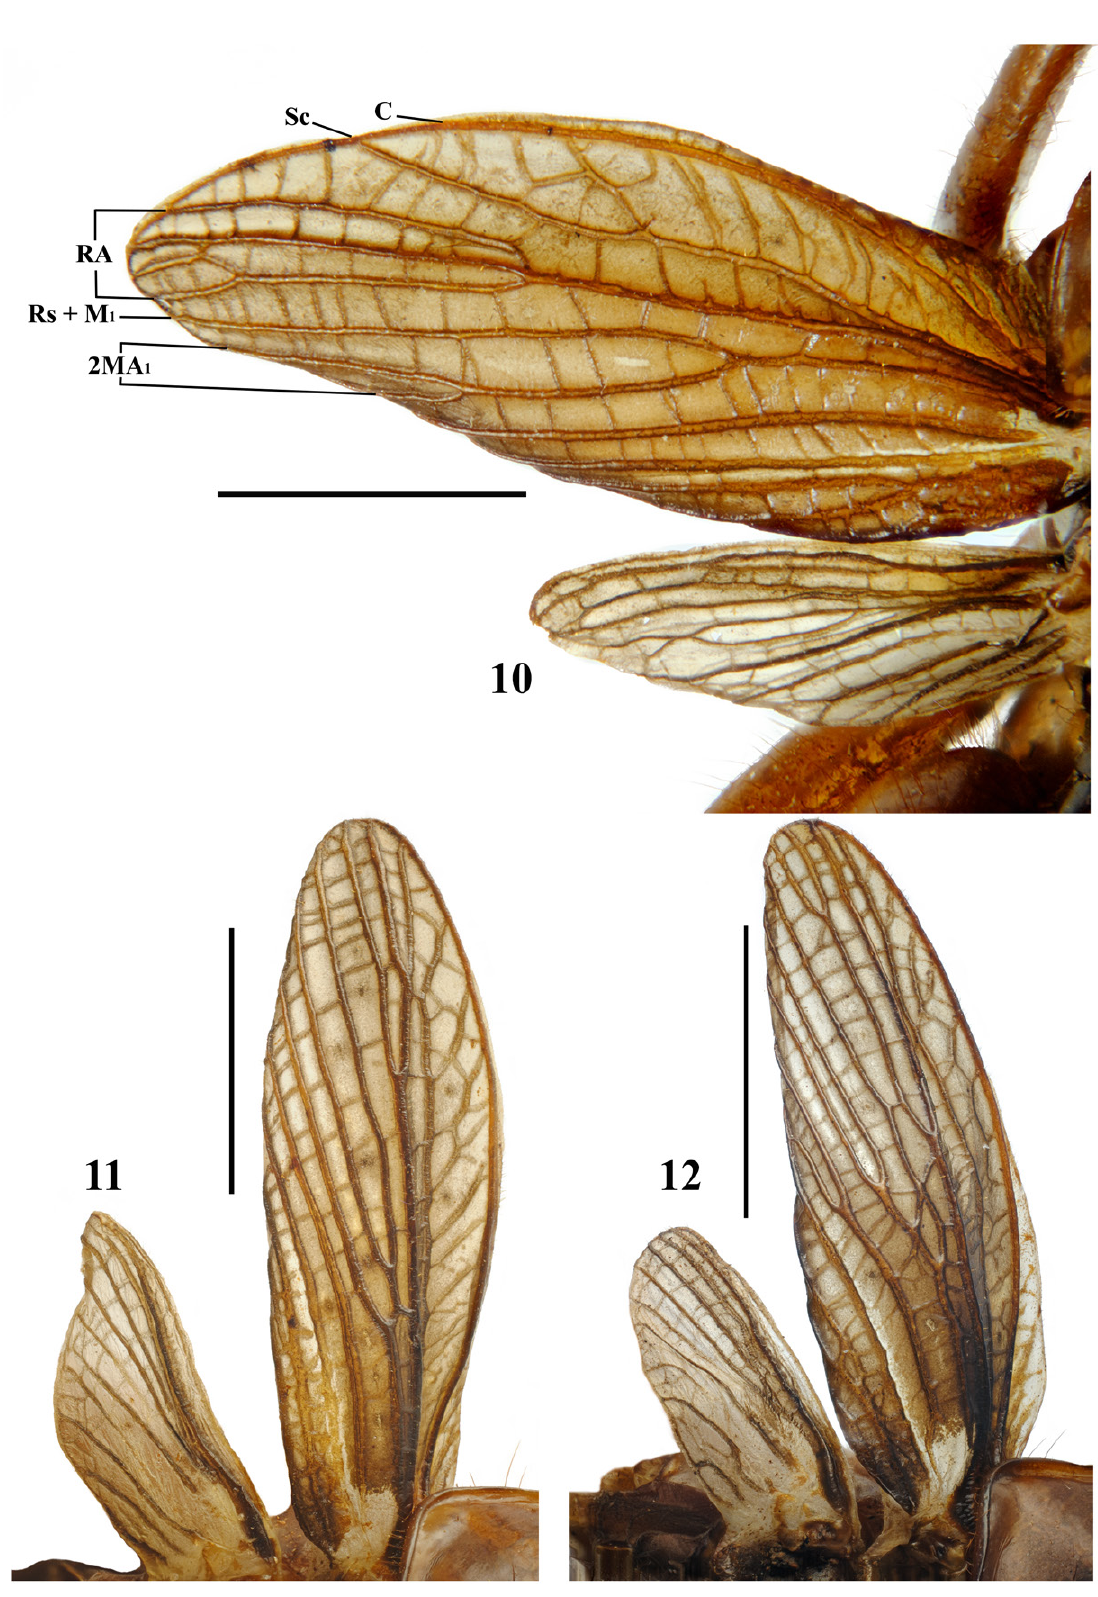
Figs 10–12. Oryctopterus varuna sp. nov., ♂. 10 . Lost specimen. 11 . Holotype (NBAIR). 12 . Paratype (NBAIR). Abbreviations: see Material and methods. Scale bars = 5